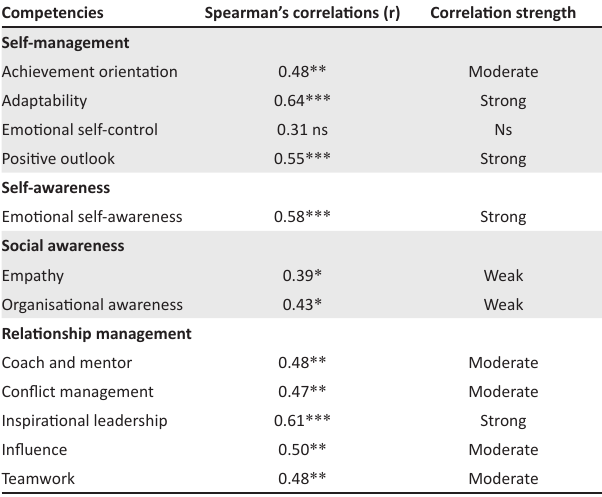
TABLE 5: Result of Spearman’s correlation to determine the relationship between leadership performance and emotional intelligence competencies.